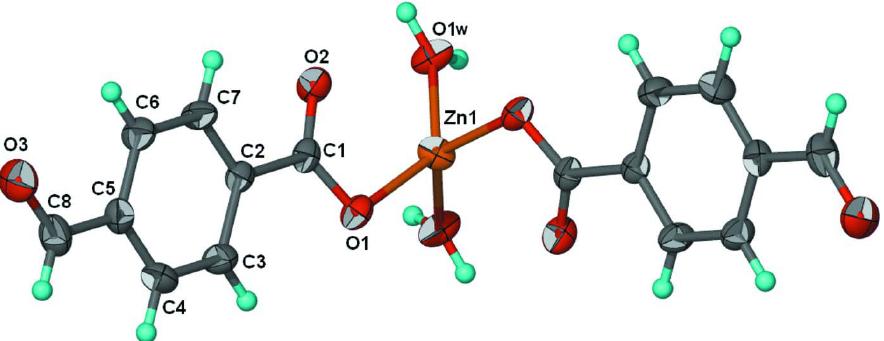
Anisotropic displacement parameter plot of (I). Displacement ellipsoids are drawn at the 50% probability level and H atoms as spheres of arbitrary